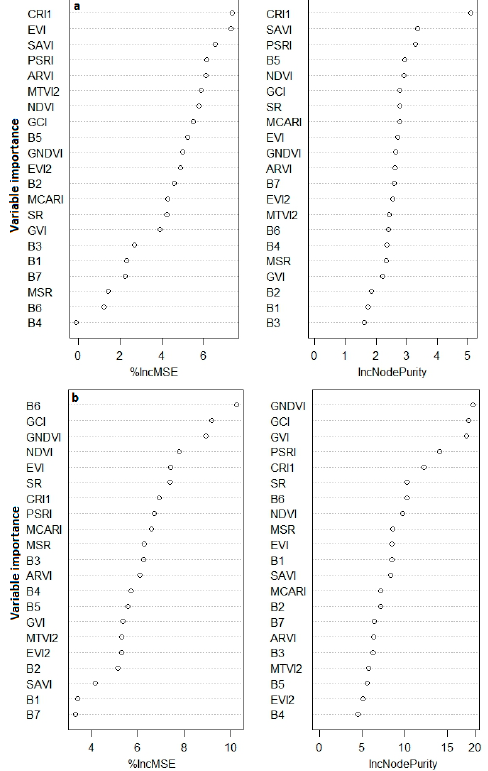
Figure 6. Important variables ranking by RF model ( a ) wet and ( b ) dry seasons. %IncMSE: percentage increased mean squared error; IncNodePurity: increased node purity.